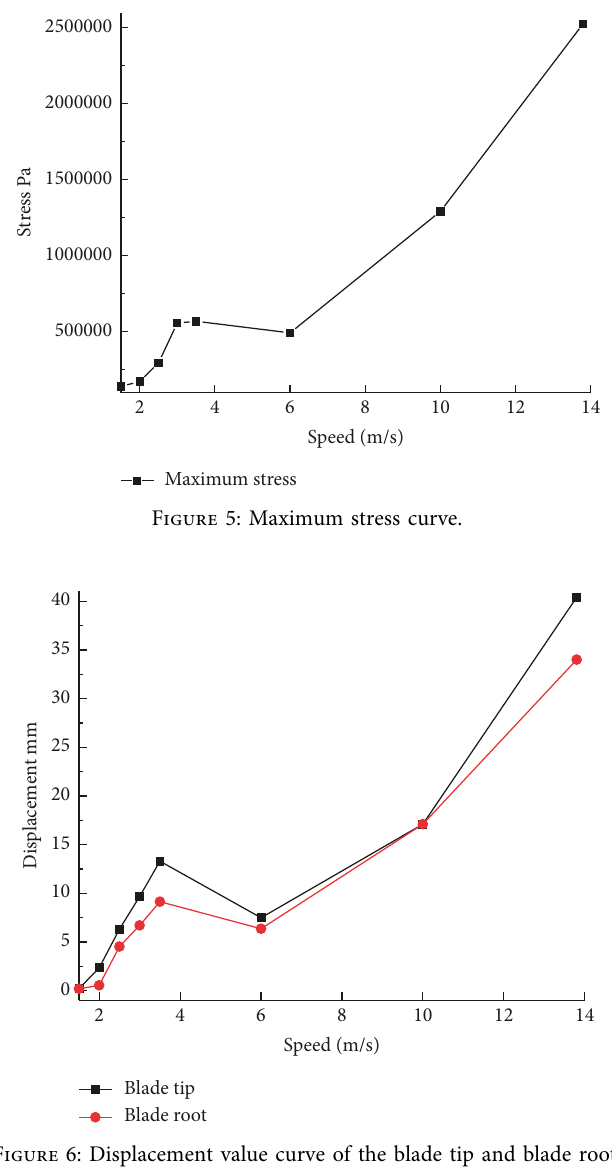
Figure 6: Displacement value curve of the blade tip and blade